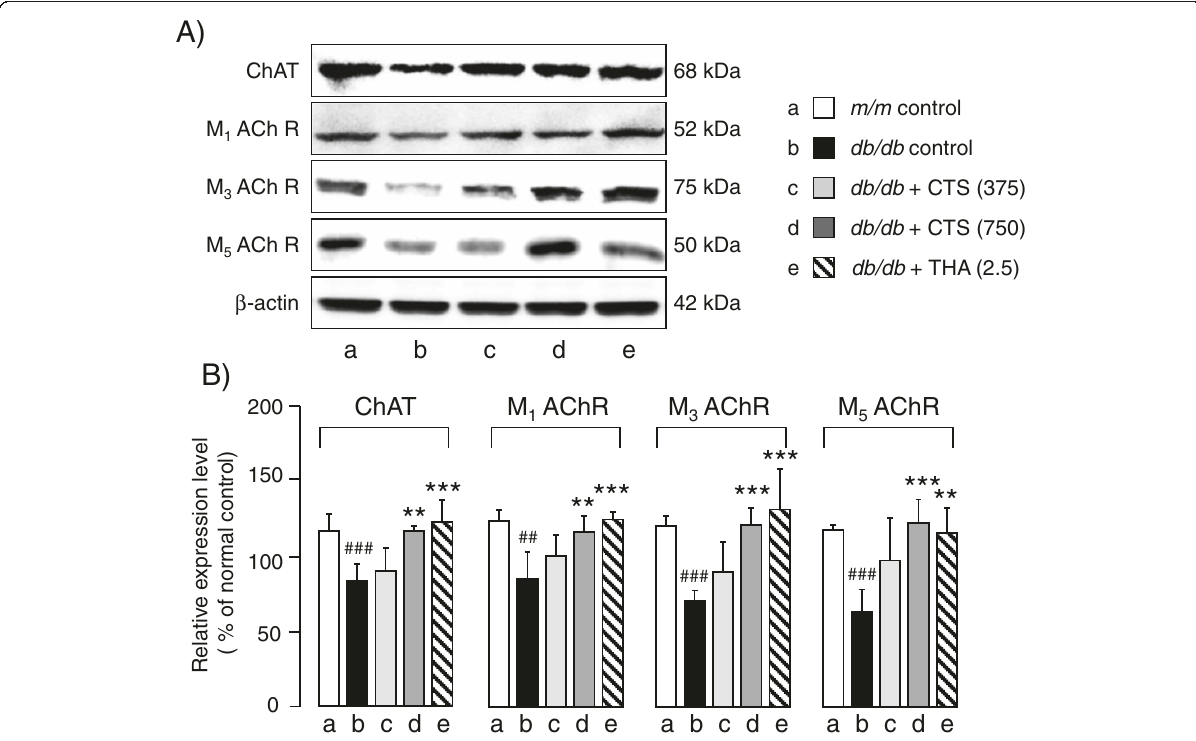
Figure 9 Effects of CTS and THA on ChAT, M 1 , M 3, and M 5 receptor protein expression in the hippocampus of db/db mouse. Typical photos indicating the expression levels of each factor in the hippocampus of vehicle-treated m/m (lane a), and vehicle (lane b)-, CTS (325 mg/kg per day: lane c; 750 mg/kg per day: lane d)-, and THA (2.5 mg/kg per day; lane e)-treated db/db mice. B) Quantitative comparisons of each factor among different animal groups were conducted as described in the text. The data are expressed as the percentage of the value obtained from naïve control m/m mice. Each data column represents the mean ± S.D. obtained from 5-6 brain samples. ## P < 0.01, ### P < 0.01 vs. vehicle- treated m/m group (Student ’ s t -test). ** P < 0.01, *** P < 0.001 vs. respective vehicle-treated db/db group (one-way ANOVA followed by Tukey